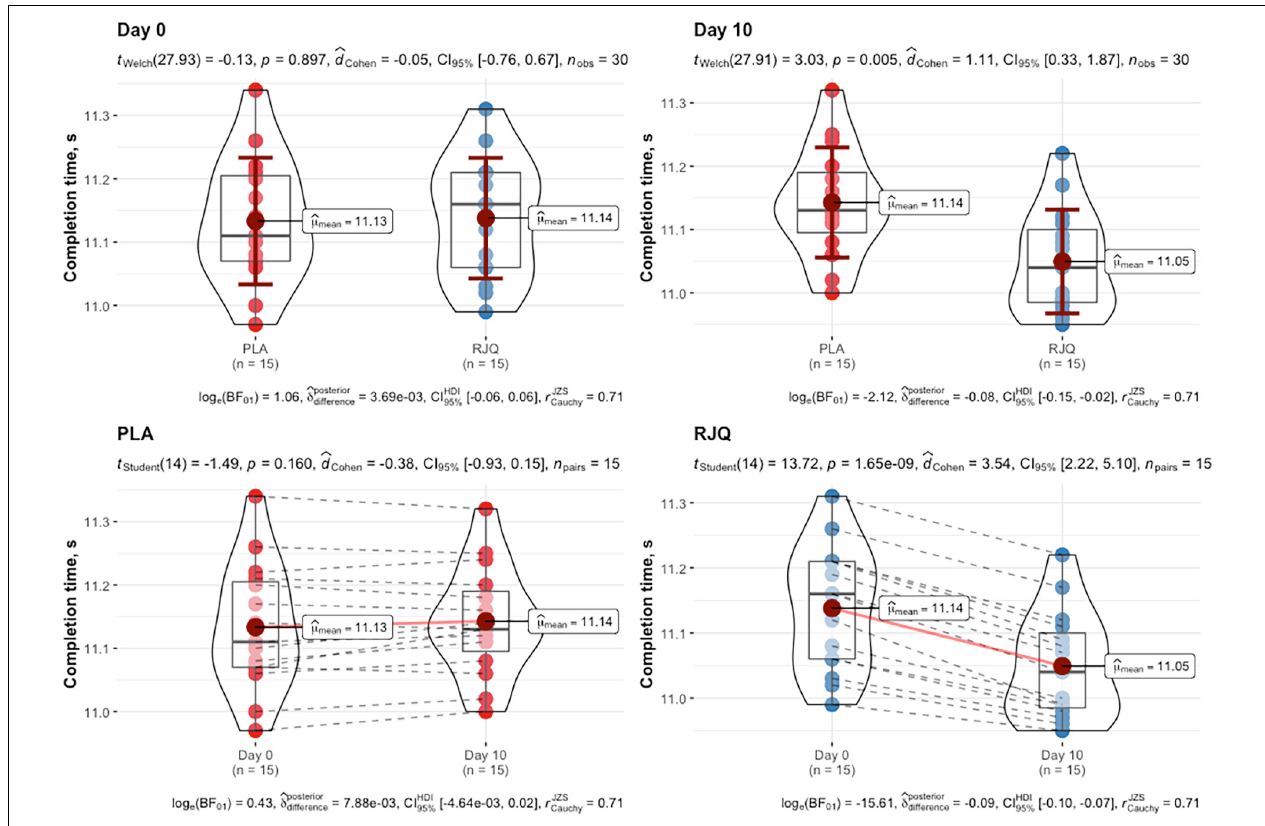
FIGURE 1 | HIIE performance expressed as time to complete exercise at baseline and day 10 of intervention between randomization arms. Data are given as means ± SD and compared by paired Student’s t -test for within-group comparison analysis and by Student’s t -test for independent data for between-group comparison analysis. n = 15 per